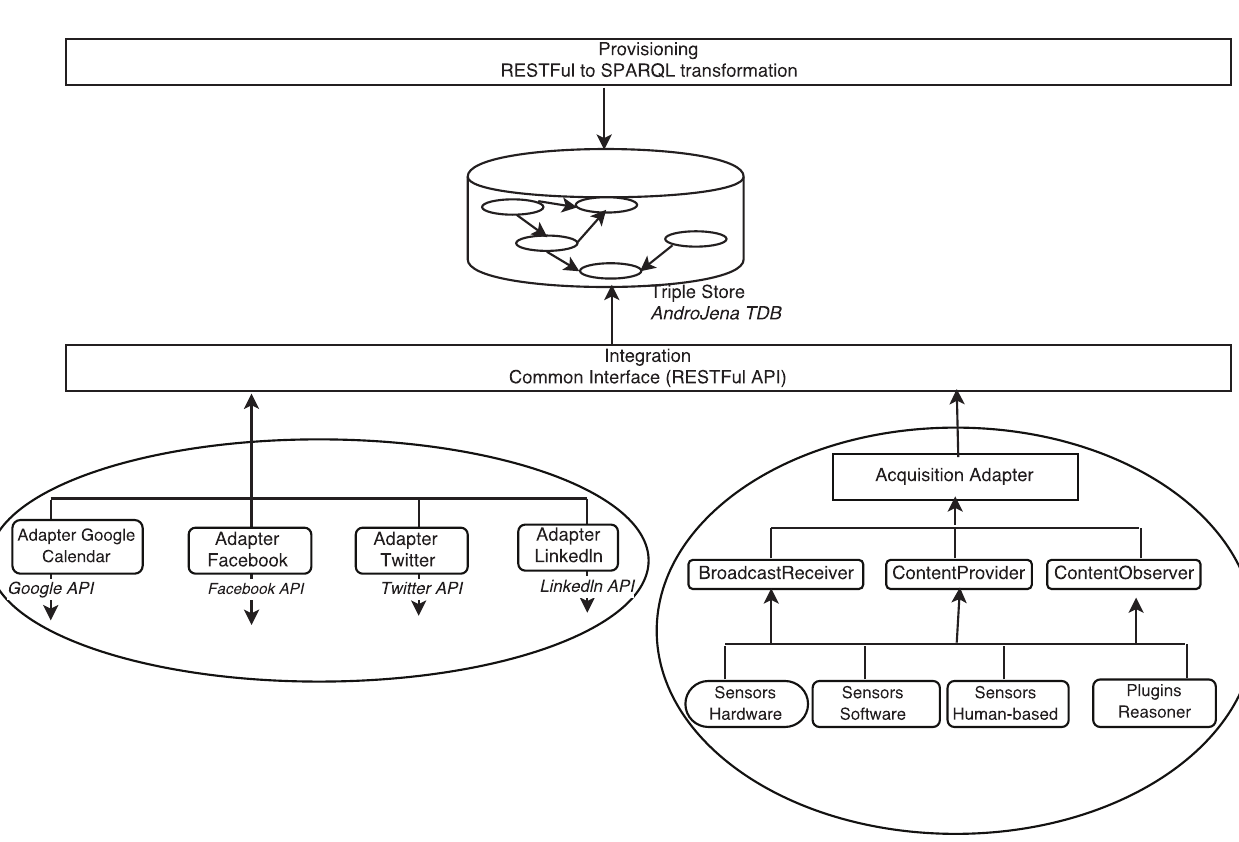
Figure 1. AndroCon System